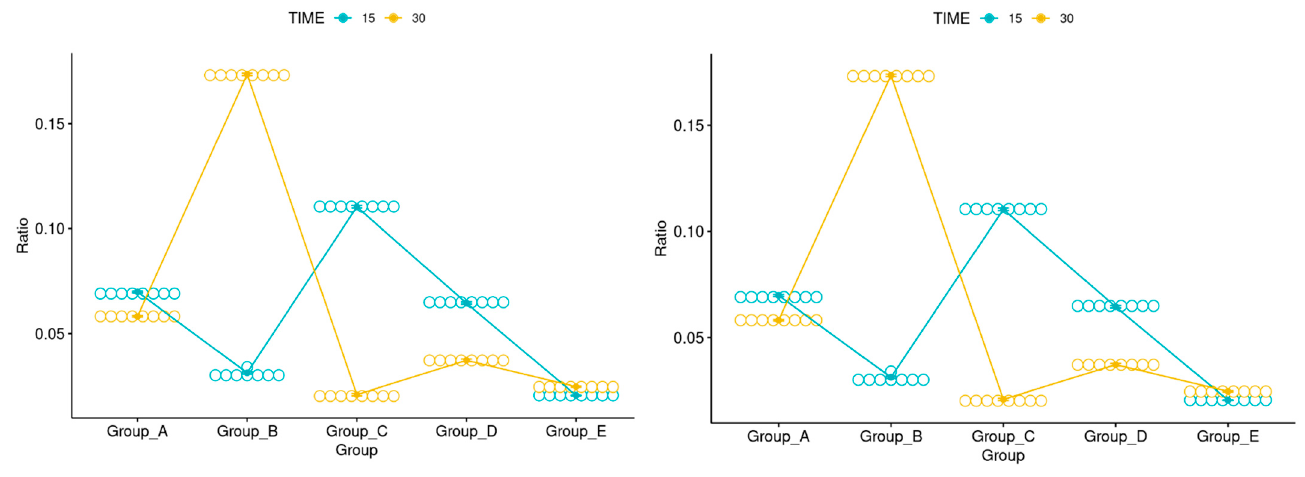
Figure 5. Ratios of the total area and the area positive for TRPV1 after immunohistochemistry assay and picture evaluation with Image Pro Plus software. Data were analyzed with a two-way ANOVA to evaluate interactions between treatment and time, while a one-way ANOVA with Tukey multiple comparisons test or with unpaired Student t-test were used to evaluate differences among groups’ fixing treatments and time, respectively.